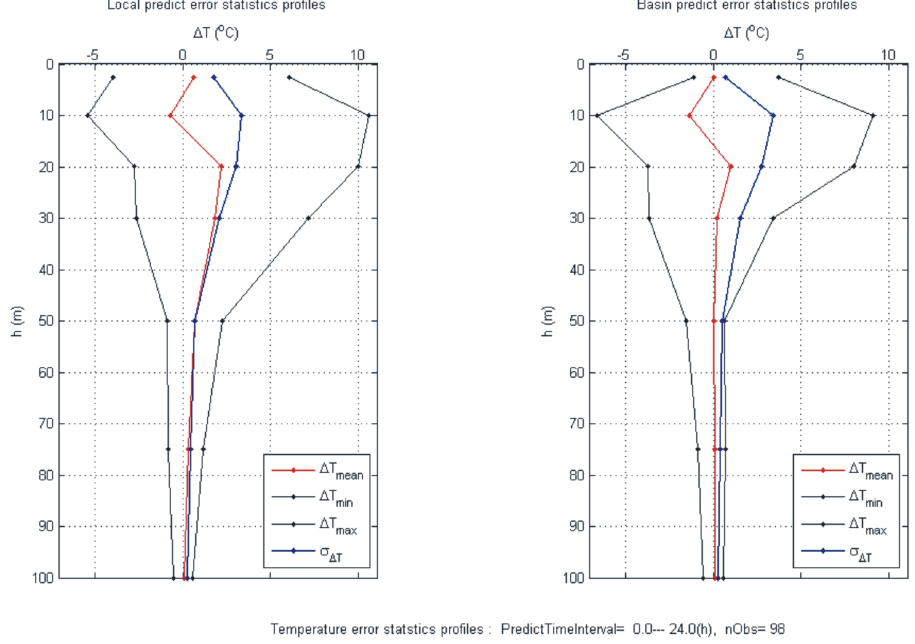
Fig. 10. Bias (red) and standard deviation (blue) of simulations and observations for the local model (left) and the basin-scale one (right) for the survey near the Crimea. Extreme deviations for every level are shown by black lines on the both